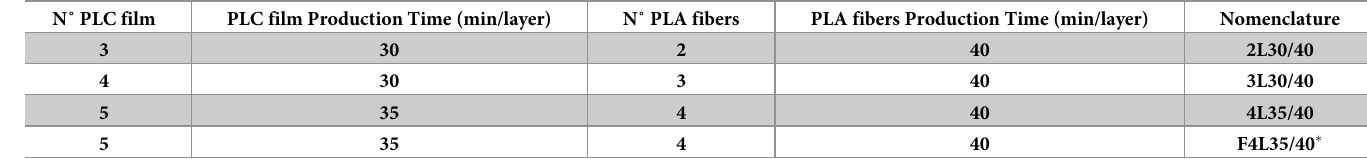
Table 1. Nomenclatures relation to the number of layers and time of layer production for each construct studied. N˚ PLC film